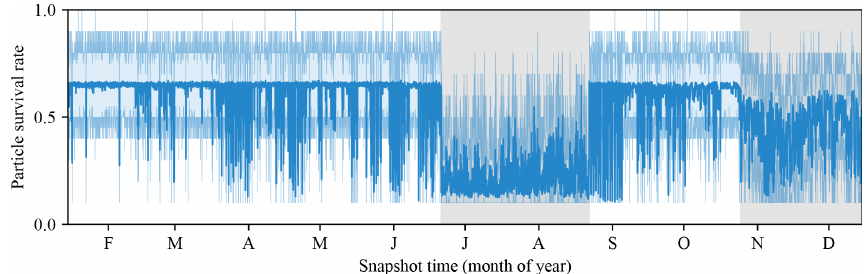
Figure 6. Particle survival rates (fraction of particles in the filter that are retained for continuing the DA) for each snapshot time in the PF likelihood estimator. The solid line indicates the mean, and the semi-transparent lines indicate the 0th–100th percentiles. The periods of time when LéXPLORE data are available are shown as shaded gray regions.